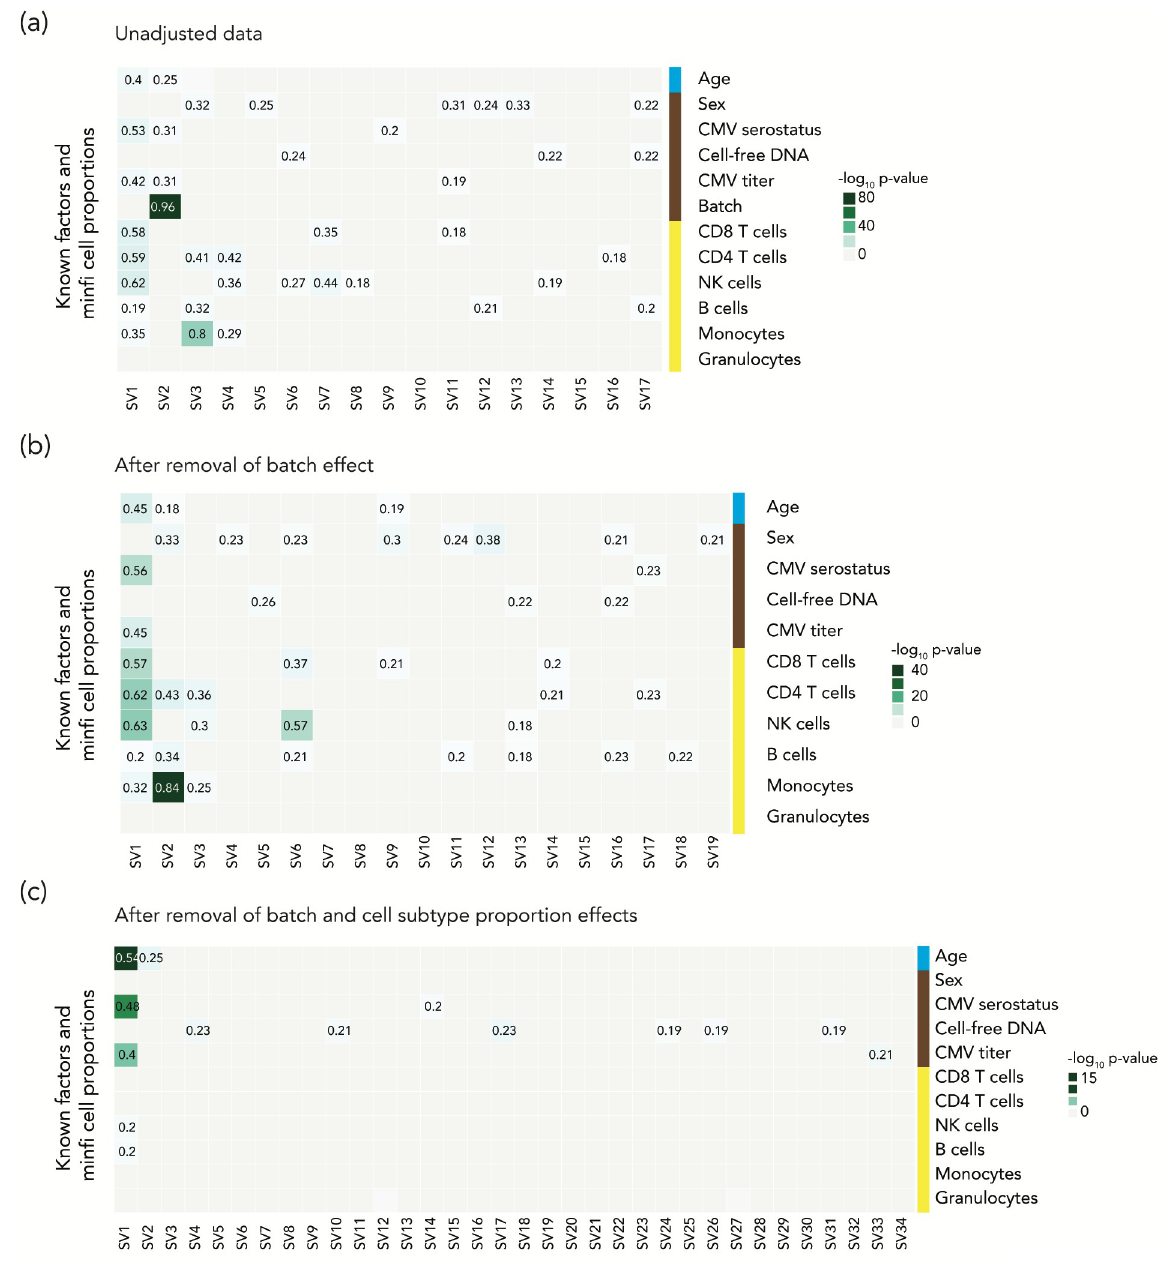
Fig 3. The SVA approach may lead to elimination of true positive results. Heatmaps show the influences on each surrogate variable (SV) of known covariates and estimated cell subtype proportions. We performed SVA on the unadjusted data (a), and on data after removal of batch effect (b) and after further adjustment for cell subtype proportion variability (c). We performed multiple linear regression models to estimate the contribution of covariates to surrogate variables. The step-wise analysis revealed that the SVA approach has effects on the phenotype of interest, especially as we eliminate some of the sources of experimental